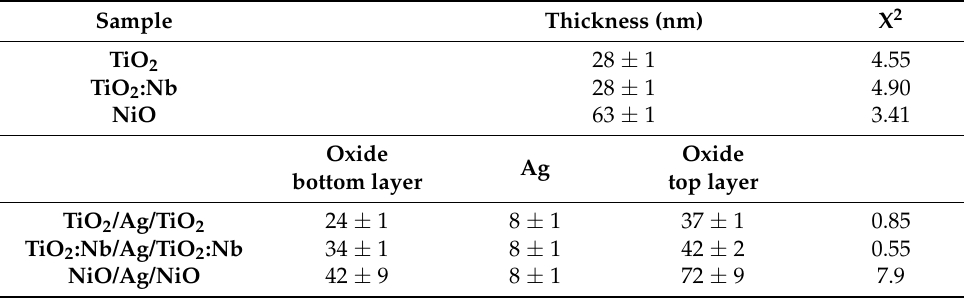
Table 3. Thicknesses obtained from ellipsometry simulations.